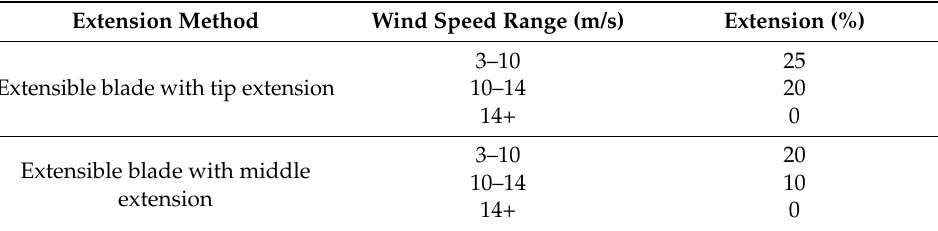
Table 4. Blade extends type in the research.